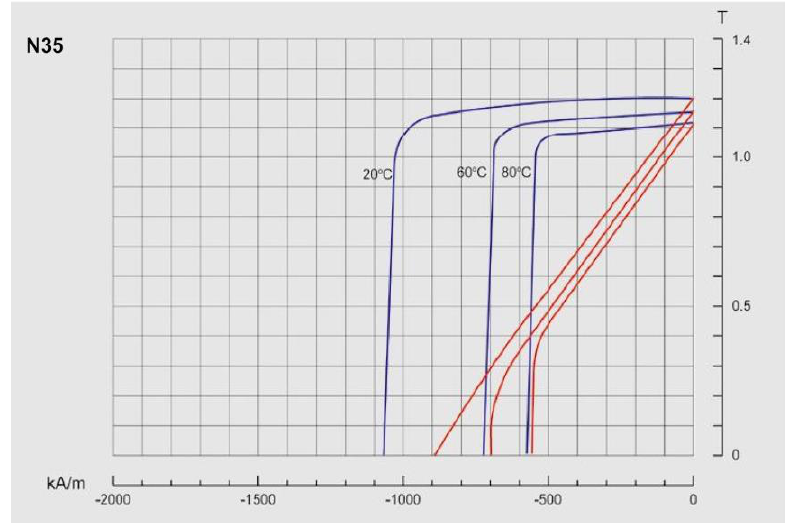
Figure 10. B-H curves of N35.